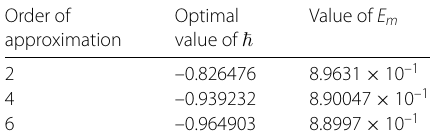
Table 3 Optimal value of (cid:2) for λ = 1